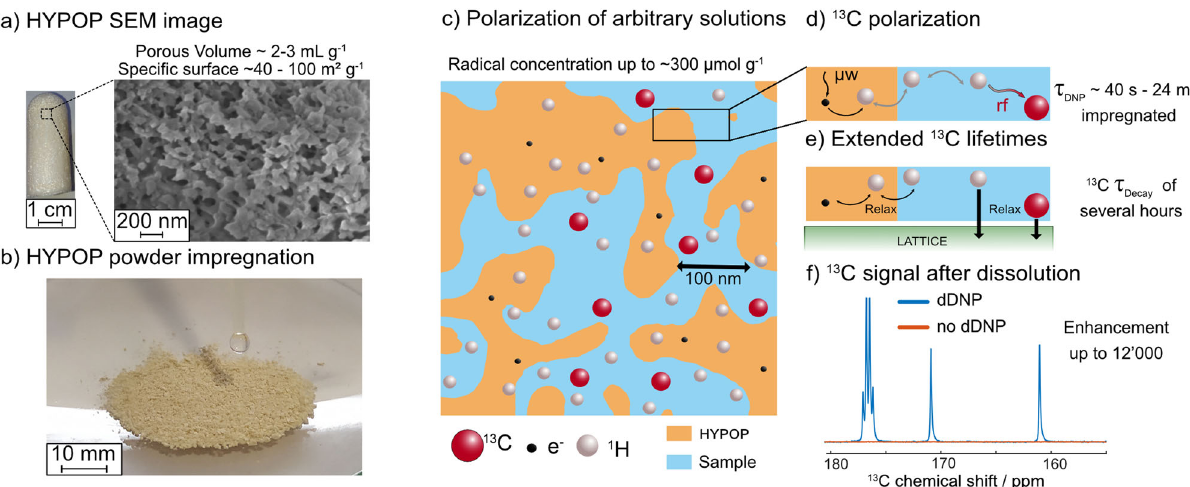
Fig. 1 Illustration of the steps from production to extraction of transportable hyperpolarization. a Scanning electron microscopy of the HYPOP material used in this study. b Photograph of the impregnation step of powdered HYPOP. c Schematic representation of the porous polymer (yellow) with its PAs (black dots) impregnated with a 13 C-labelled molecule (red dots) in aqueous solution (blue). 1 H spins (grey dots) are abundant both in the HYPOP material and aqueous solution. d Schematic representation of the polarization transfer from the electrons of the PAs located within the HYPOP material to the 1 H nuclei located within the HYPOP material, followed by 1 H ↔ 1 H spin diffusion across the material interface towards the aqueous frozen solution impregnated in the pores, and fi nally ended by a cross-polarization (CP) transferring the 1 H polarization to the 13 C spins of the target molecules. e Schematic representation of the slow 13 C nuclear spin-lattice relaxation in solid state, mostly free from any paramagnetic relaxation since the 13 C spins are physically well isolated from the PAs. f Carbonyl region of the 13 C-NMR spectrum measured on a 80 MHz Bruker BioSpin Fourier 80 benchtop spectrometer (1 scan, 2 s), of a sample containing 1 M [1- 13 C]sodium acetate, 1 M [1- 13 C]sodium formate and 1 M [1- 13 C]glycine, hyperpolarized with HYPOP materials, displaying a liquid-state polarization enhancement exceeding